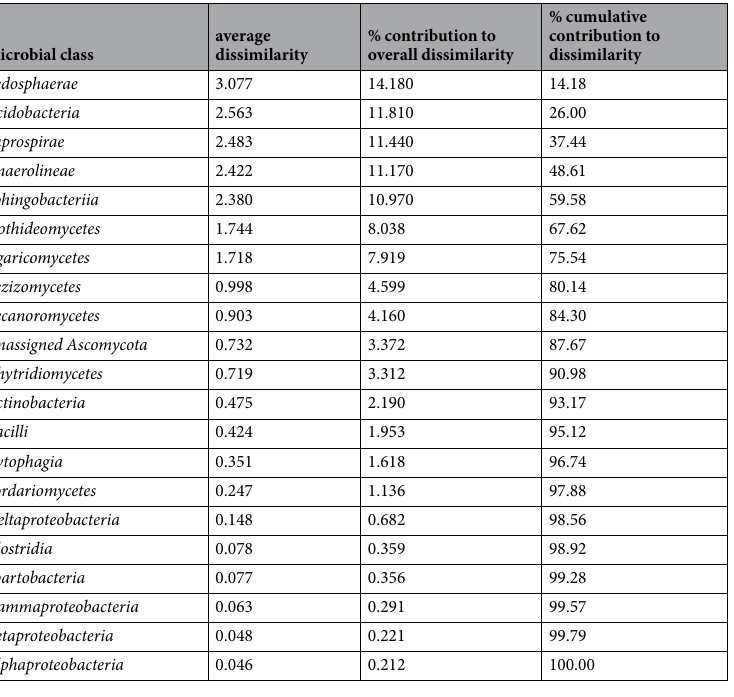
Table 3. SIMPER analysis identifies top abundant taxa that contributed most of the dissimilarities ( > 1%) between the active microbial rhizosphere communities from soil initially containing a sterile (Control)/non sterile (Vermicompost)